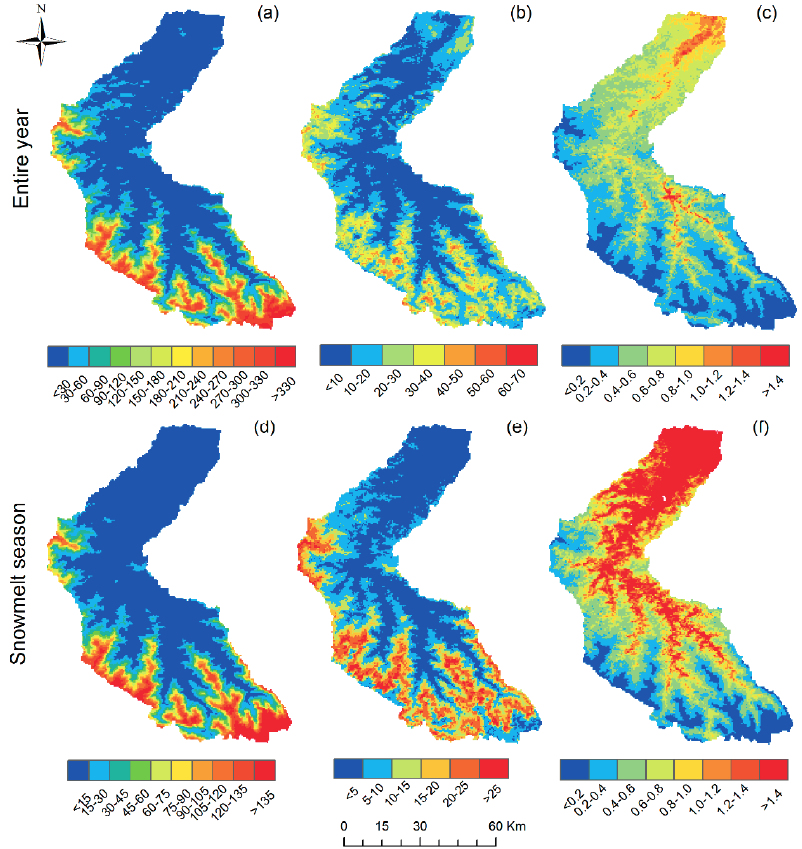
Figure 6. Spatial distributions of the ( a ) mean, ( b ) standard deviation, and ( c ) CV of SCD in a hydrological year, and the ( d ) mean, ( e ) standard deviation, and ( f ) CV of SCD in snowmelt season for 10 hydrological years from October 2002 to September